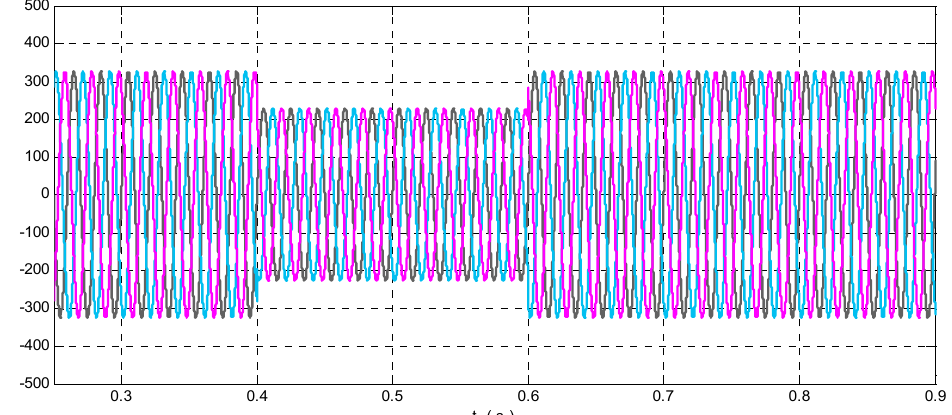
Figure 10. Simulation of the DC-bus voltage.